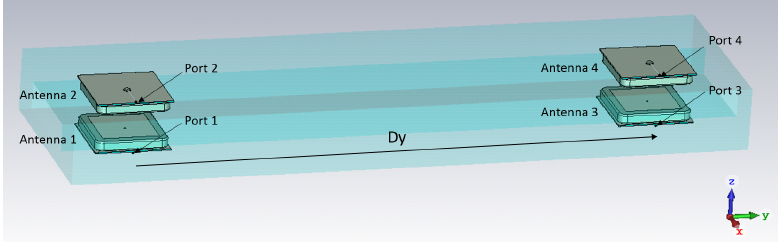
Figure 6. Four patch antennas placed on the entrance housing. Patch antennas are fed by a coaxial probe. The antenna size is 50mm × 50mm ×